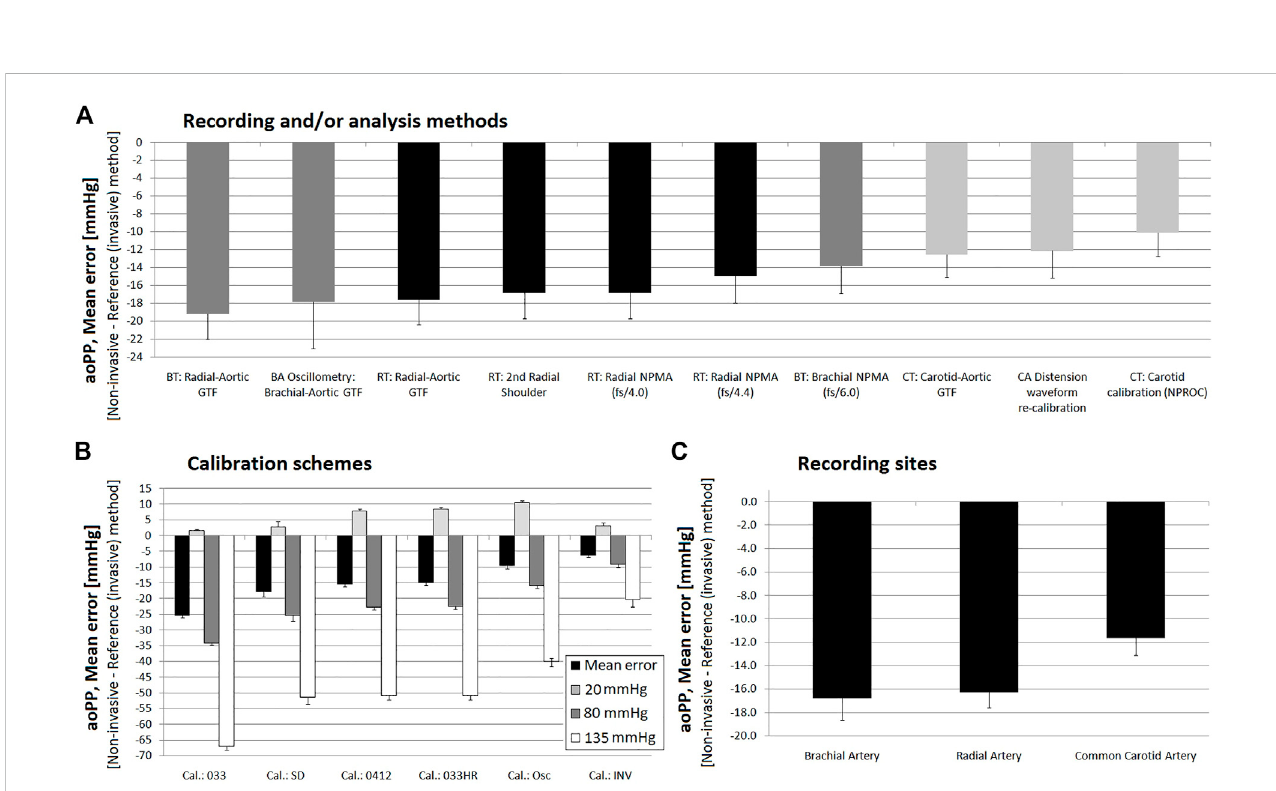
FIGURE 9 Pooled results for Bland-Altman derived mean errors (and lower or upper 95% con fi dence limit) obtained for comparisons between non-invasive and invasive aoPP measurements. Results grouped according to: (A) recording and/or analysis methodology; (B) calibration scheme; (C) recording site.